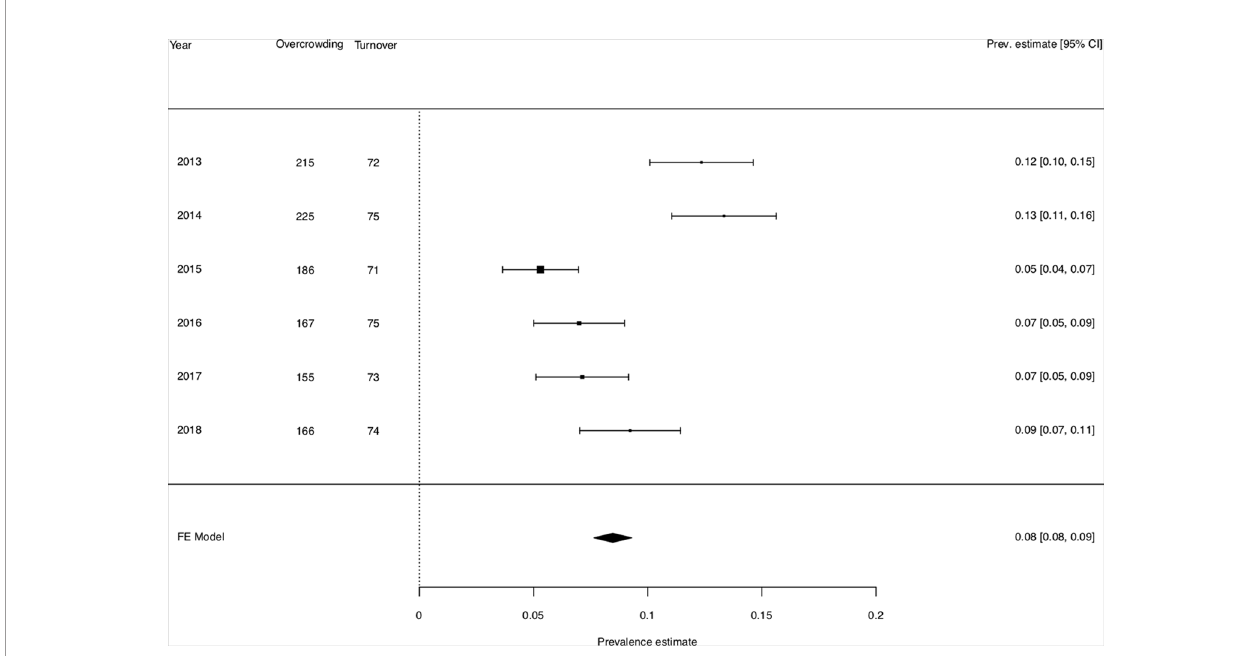
FIGURE 1 | Forest plot of the effect of overcrowding and turnover on prison violence, sorted by overcrowding rate. 95% CI: 95% con fi dence intervals. Whiskers represent 95% CI for the prevalence estimate of each year. Prevalence estimates are reported for assaults requiring immediate medical attention. Overcrowding and turnover are reported as